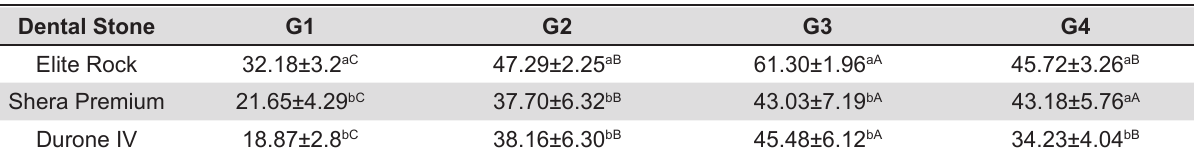
Table 4 - Mean values of compressive strength (MPa) and standard deviation as function of the interaction of the drying method and stone